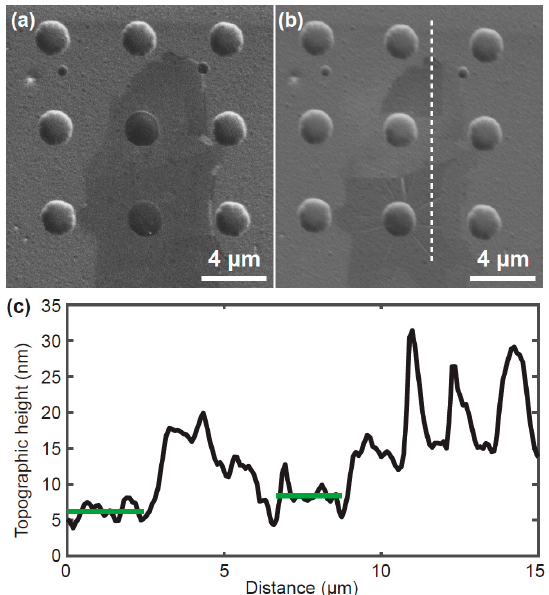
Figure 4. ( a ) SEM image of the sample after annealing at 200 °C, ( b ) SEM image after annealing at 500 °C, and ( c ) an atomic force microscopy (AFM) height profile down the dotted line indicated in ( b ) with two mean heights marked for ( left ) the SiO 2 substrate and ( right ) the attached thin region.